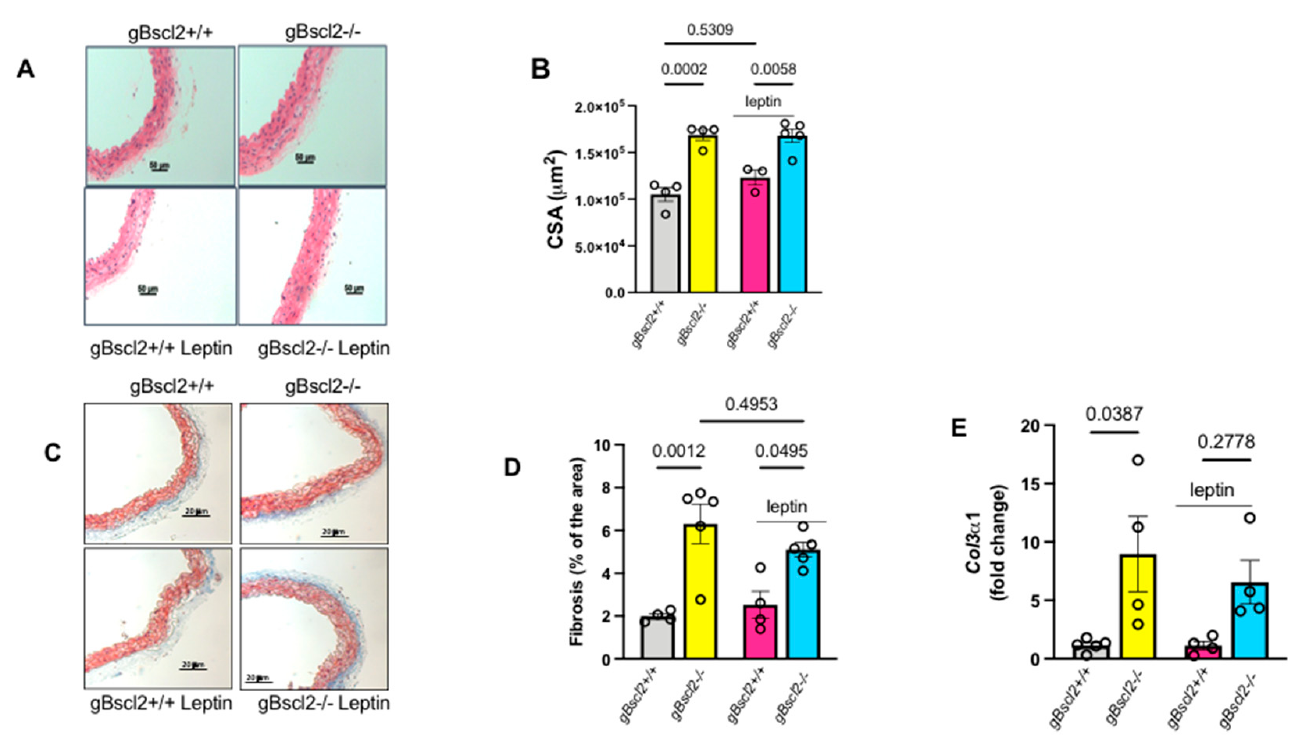
Figure 2. Leptin treatment does not restore vascular remodeling and fibrosis in lipodystrophic mice. Hematoxylin and Eosin staining ( A ), cross-sectional area quantification ( B ), Masson’s trichrome staining ( C ), fibrosis quantification ( D ), and collagen 3 α 1 (Col3 α 1) gene expression ( E ) in thoracic aortas from wild-type (gBscl2 +/+ ) or Bscl2 deficient mice (gBscl2 -/- ) treated or not with leptin (0.3 mg/Kg/day for 1 week, via osmotic mini-pump). Data are presented as mean ± S.E.M. N = 3–5. p < 0.05 is considered statically different between groups.